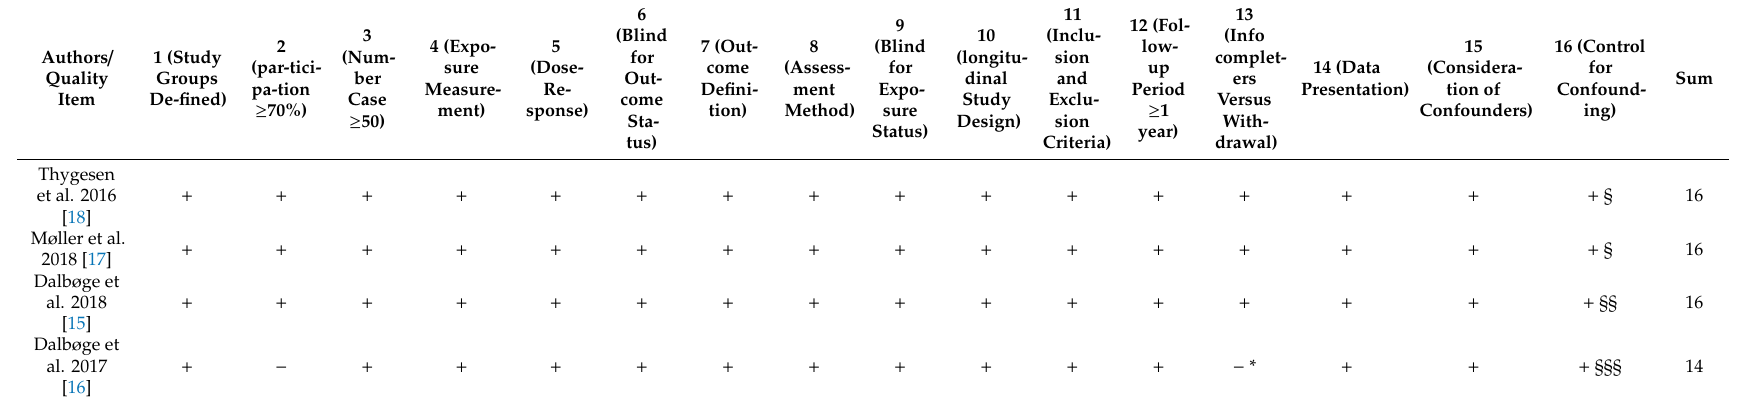
Table 2. Methodological quality scores of 16 items for studies regarding risk factors (only publications not mentioned by van der Molen et al. 2017